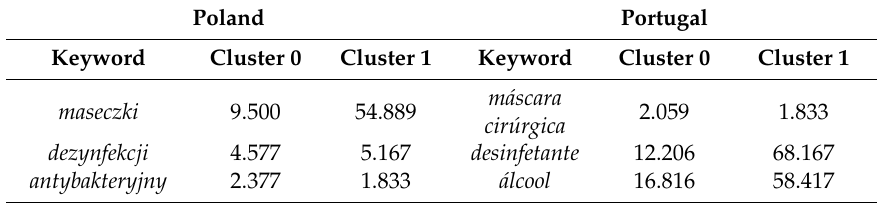
Table 3. Information about the centroids of the clusters for Poland and Portugal.